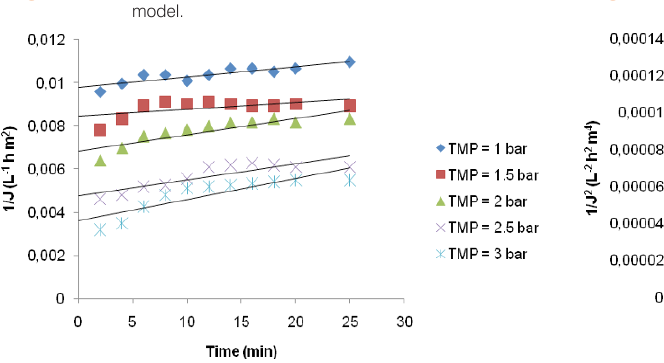
Figure 5. Permeate flux predicted by the standard blocking model.